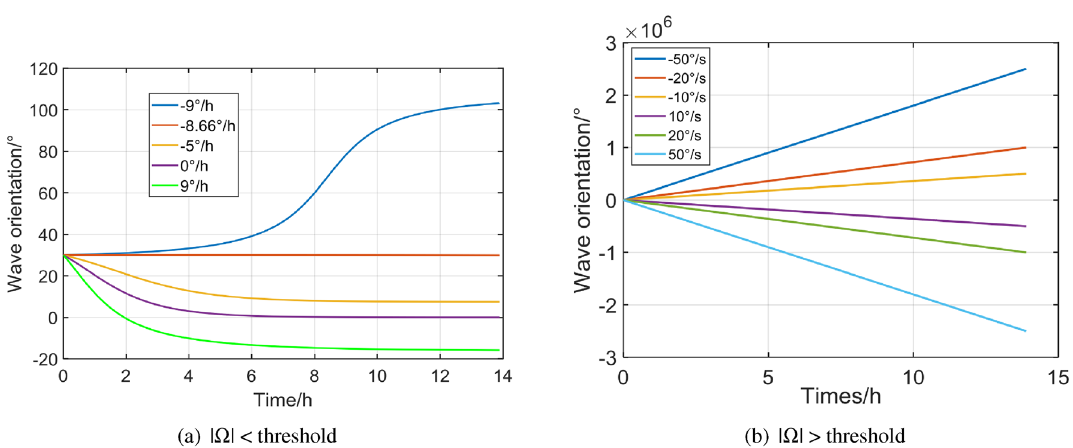
Figure 8. Time domain responses of HRG with input behind/beyond the dead-zone